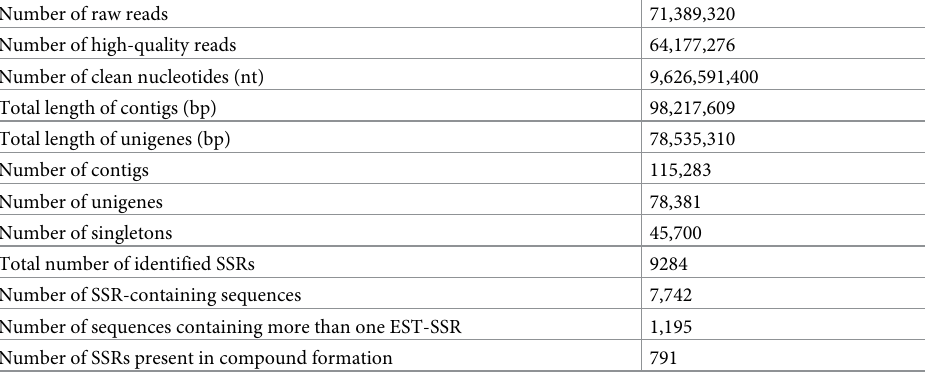
Table 1. Summary of the analysis of A . emeiensis transcriptomic